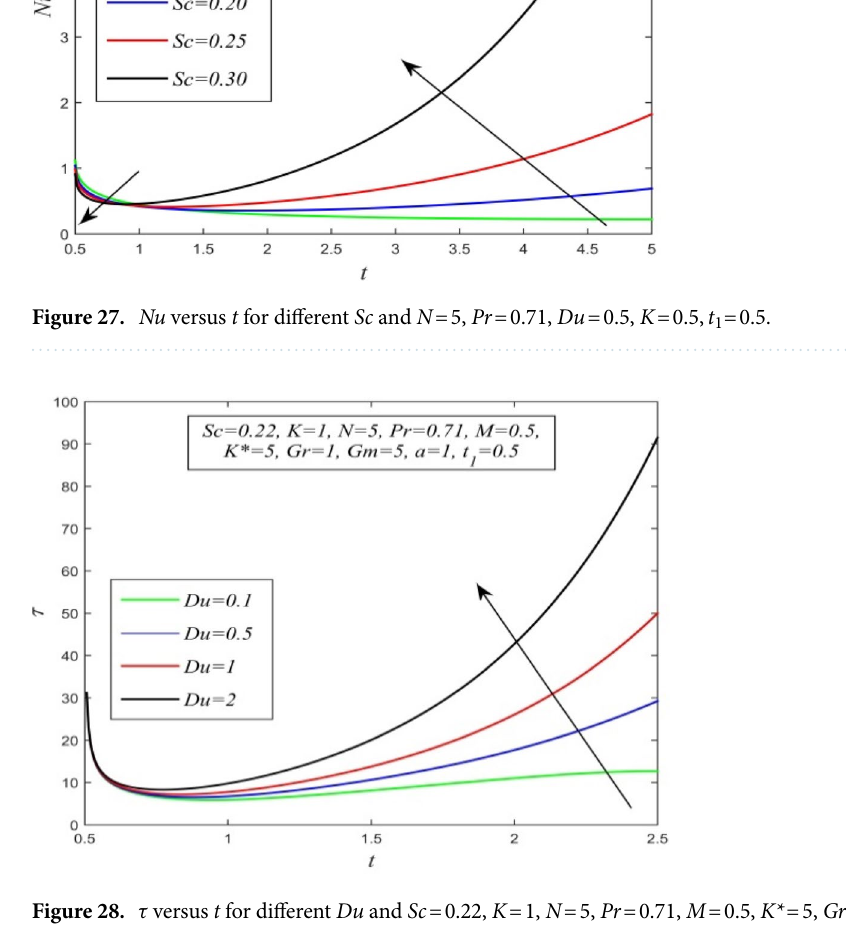
Figure 28. τ versus t for different Du and Sc = 0.22, K = 1, N = 5, Pr = 0.71, M = 0.5, K* = 5, Gr = 1, Gm = 5, a = 1, t 1 =